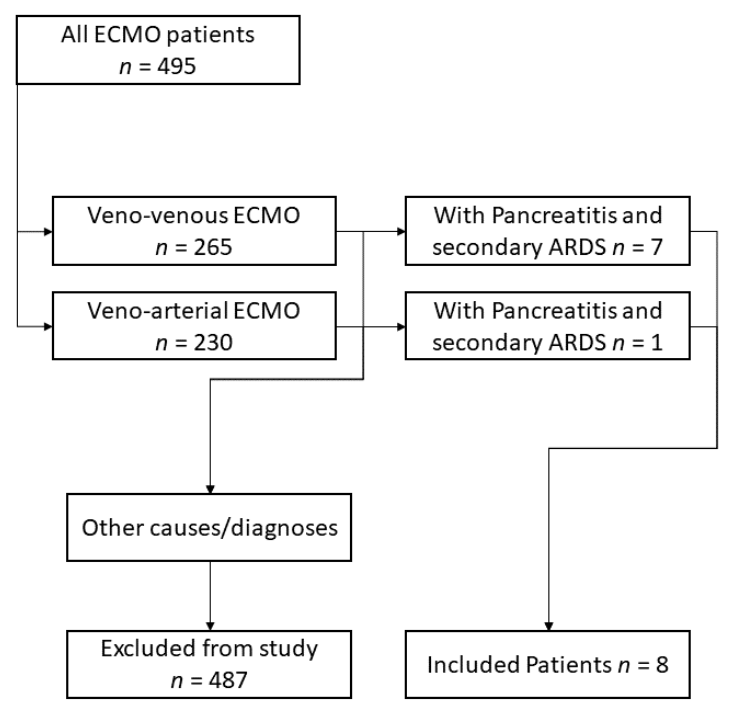
Figure 1. Inclusion process for the selected patient cohort. ECMO: Extra Corporeal Membrane Oxygenation, ARDS: Acute Respiratory Distress Syndrome